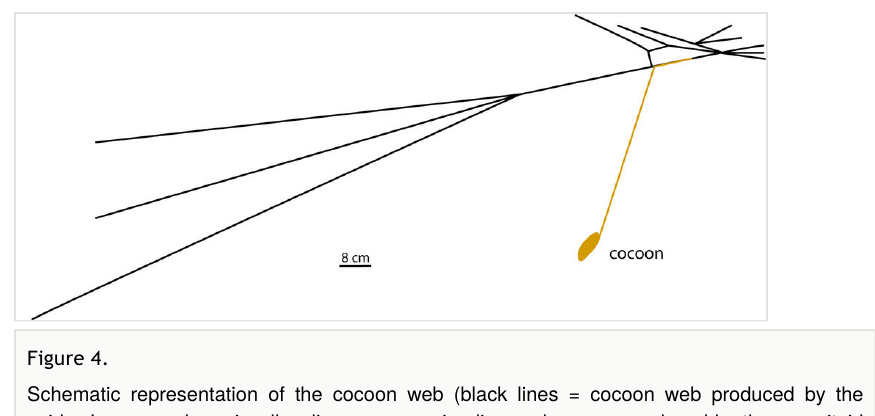
Schematic representation of the cocoon web (black lines = cocoon web produced by the spider Leucauge henryi ; yellow line = suspension line and cocoon produced by the parasitoid Hymenoepimecis manauara